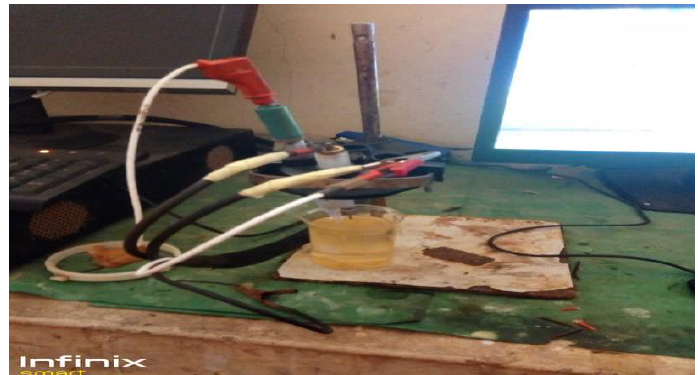
Figure 4: Electrochemical measurement analysis setup